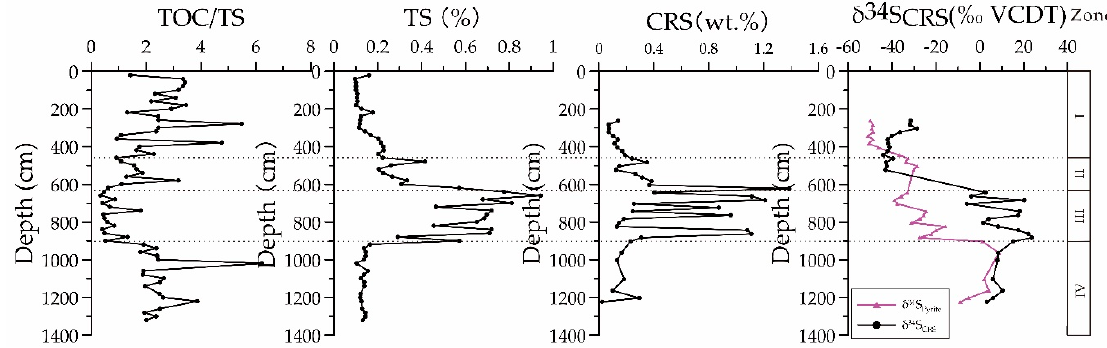
Figure 4. The contents of total sulfur (TS) and chromium reducible sulfur (CRS), and TOC/TS ratios, and sulfur isotopes of CRS ( δ 34 S CRS ) with depth in sediments of site 973-4. δ 34 S Pyrite values of bulk sediments in site 973-4 were taken from Lin et al. [47].